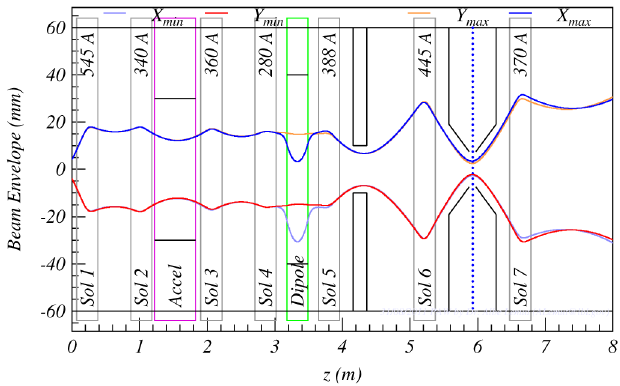
FIG. 5. 4 He þ 50 keV, 50 mA (2.5 kW, neutralization 90%, no postacceleration) beam envelopes through the gas-jet target station beam line. The dotted blue vertical line represents the gas-jet target location.